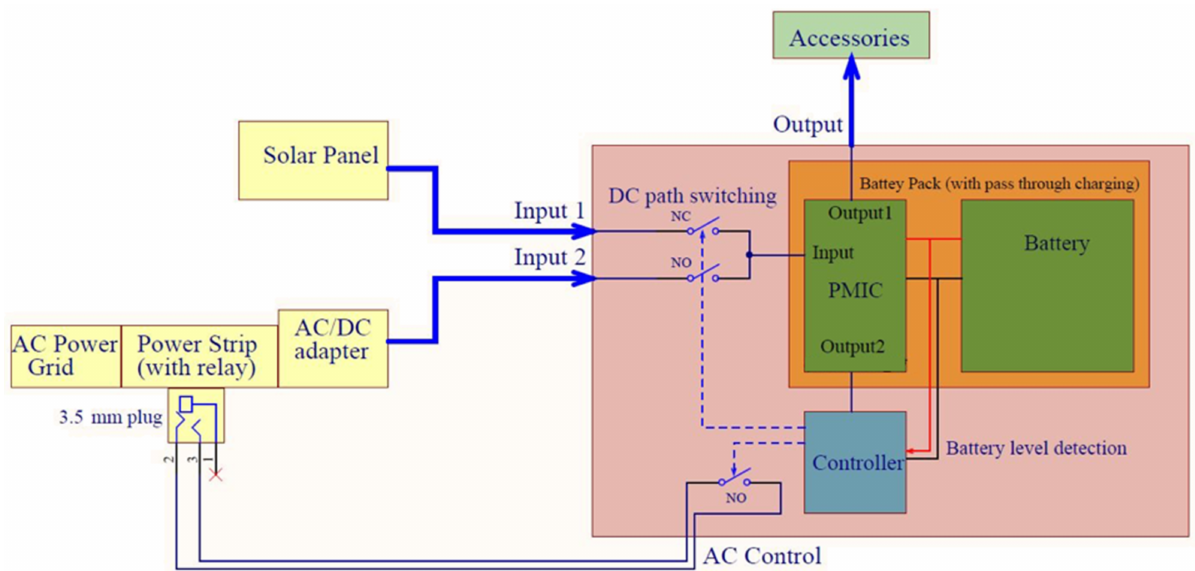
Figure 7. Statewide electrical Block diagram for the HERo. (Source: